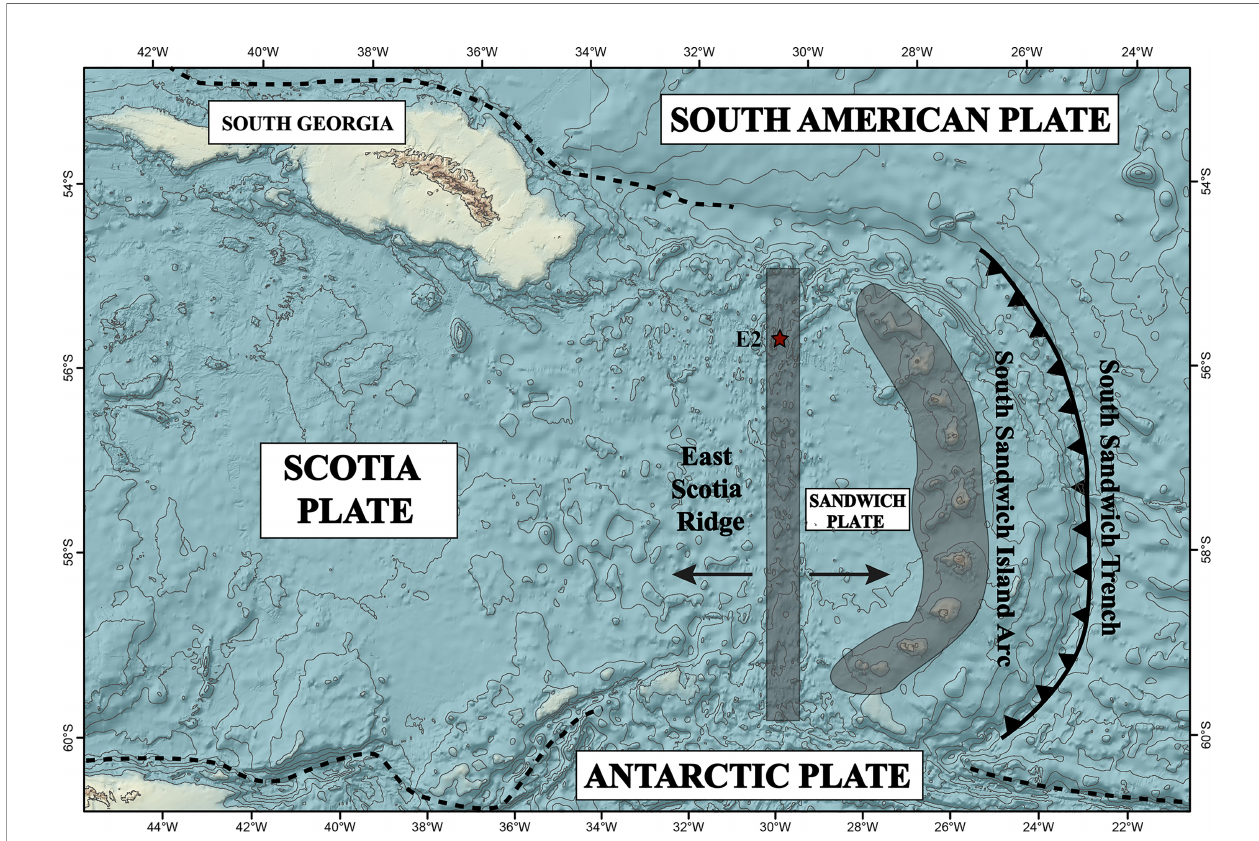
FIGURE 1 | Regional map showing the East Scotia Ridge – back-arc basin (ESR), South Sandwich Island arc (SSIA), associated plate tectonics and the location of E2 hydrothermal vent fi eld (red star) in the Scotia Sea. Adapted after Leat et al.